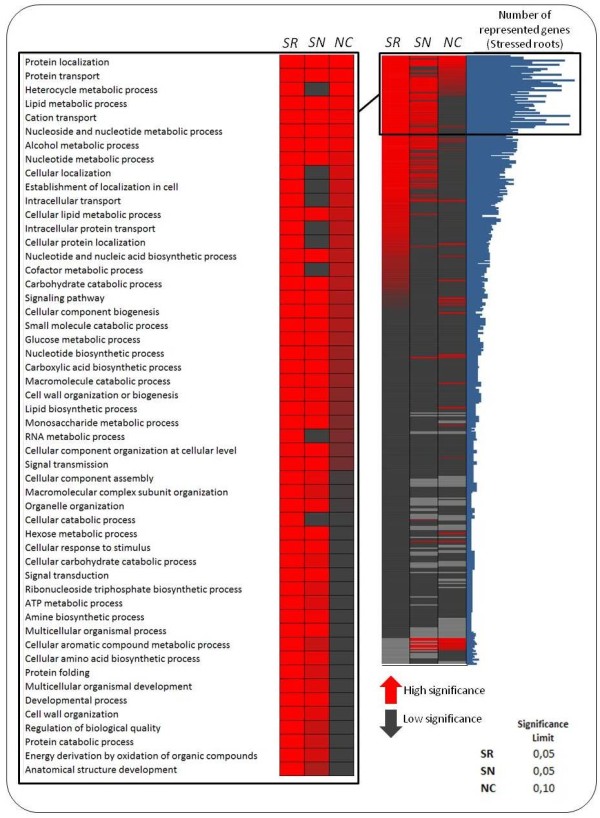
GSR analysis of over-represented GO biological terms in salt-stressed roots and nodules. Right panel: Graphic representation of significant over-represented GO biological processes in stressed roots (SR), stressed nodules (SN), and non-stressed nodules versus non-stressed roots (NC). Numbers of represented genes per GO category in salt stressed roots are represented by the blue bars next to the heat map. Left Panel: Detail showing the 52 most over-represented biological processes for salt stressed roots, compared to stressed and control nodules.